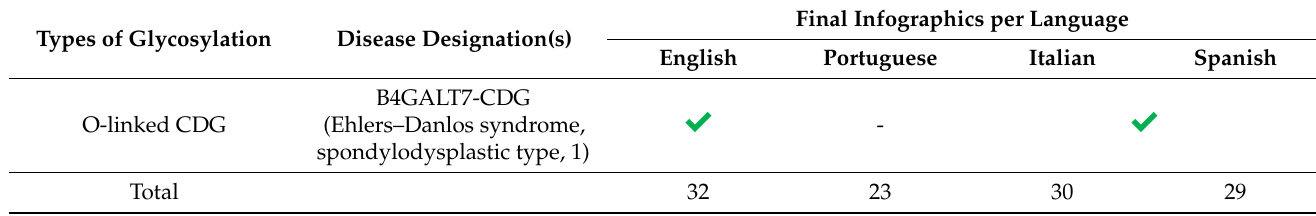
Table 3. Cont. Table 3. Finished CDG infographics by different types of glycosylation. Table 3. Finished CDG infographics by different types of glycosylation.